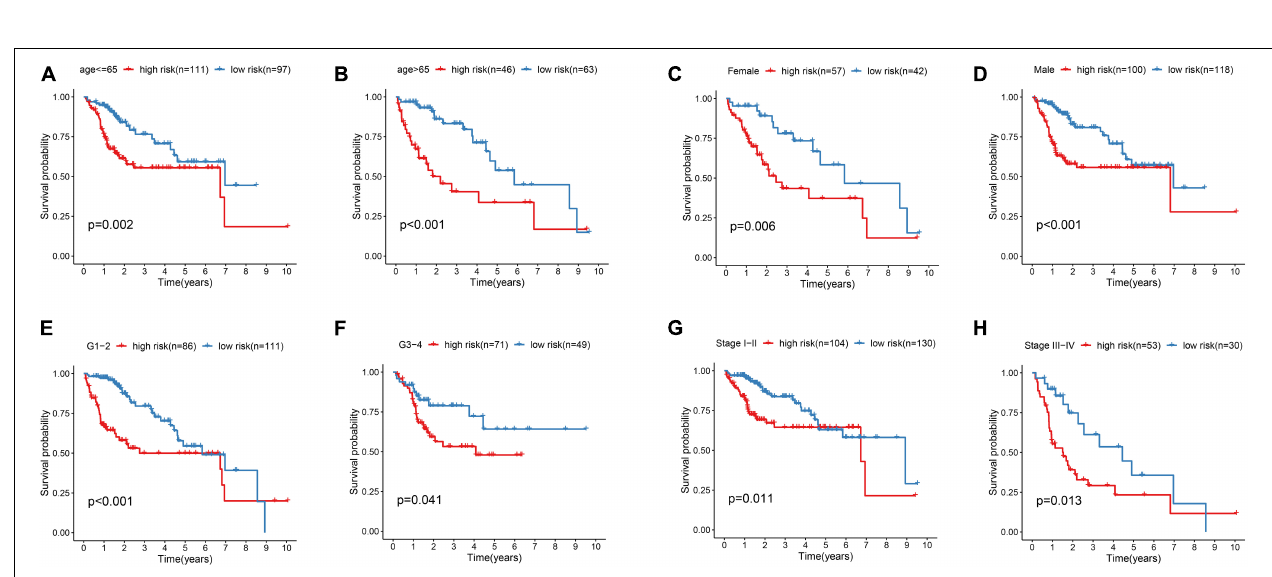
Frontiers in Genetics |